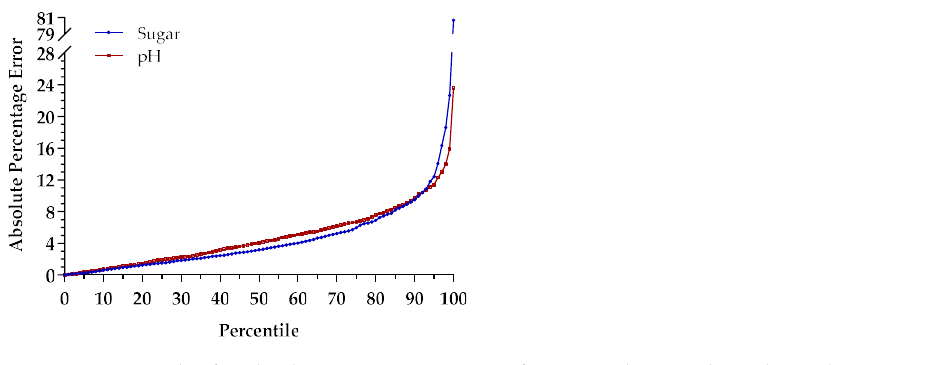
Figure 6. Percentiles for absolute percentage error of sugar and pH in the independent test set (TB and TN). Table 5. Predictive results of sugar and pH for 1D CNN tested with samples of TN and TB varieties.